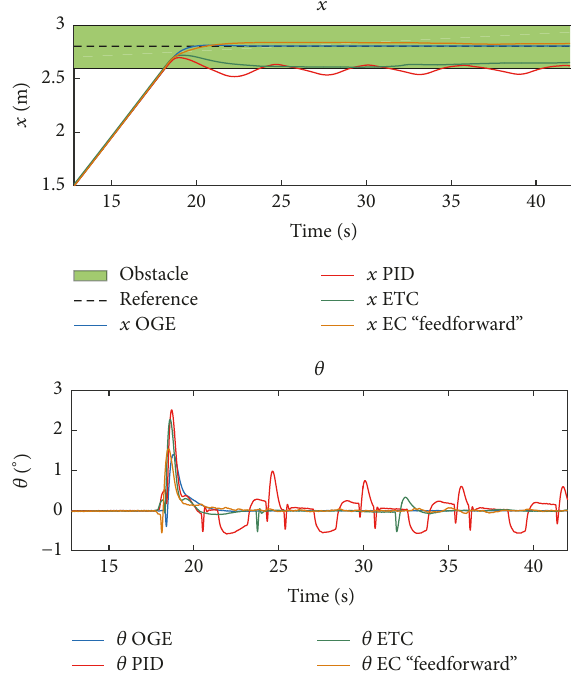
Figure 24: Hovering in partial ground effect: comparison of controllers.